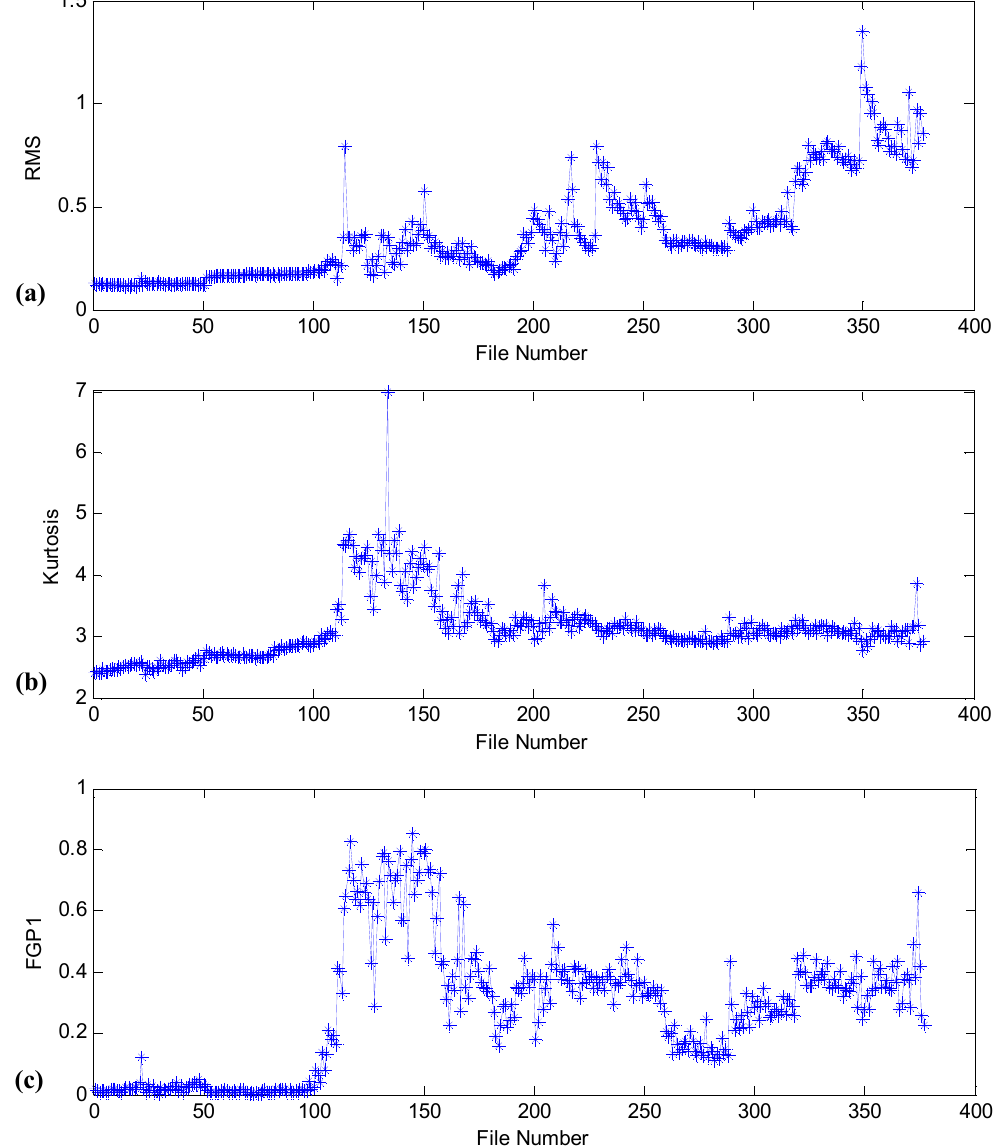
Figure 9. Comparison results of RMS, kurtosis, and FGP1 in fan bearing health assessment: ( a ) RMS; ( b ) kurtosis; ( c )